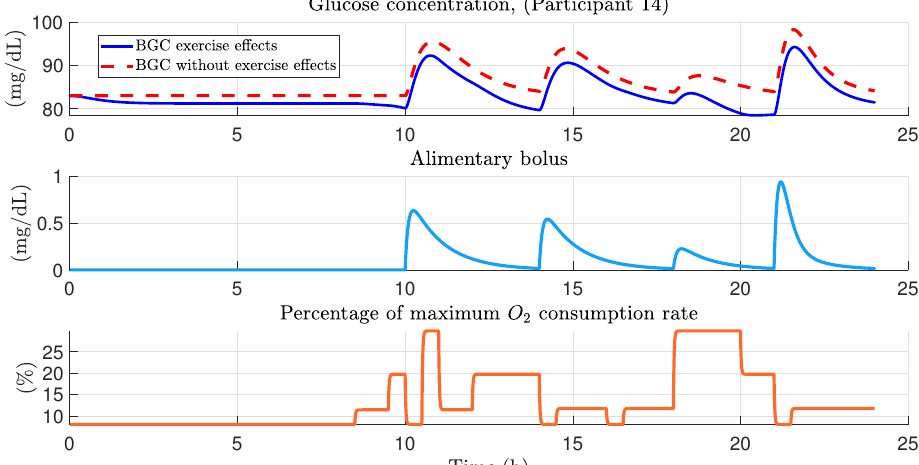
Figure 5. Variation of blood glucose concentration in the participant 14. Graphical representation of the effect of physical activity and diet in participant 14, placing in a dashed line the glucose dynamics without considering physical activity.